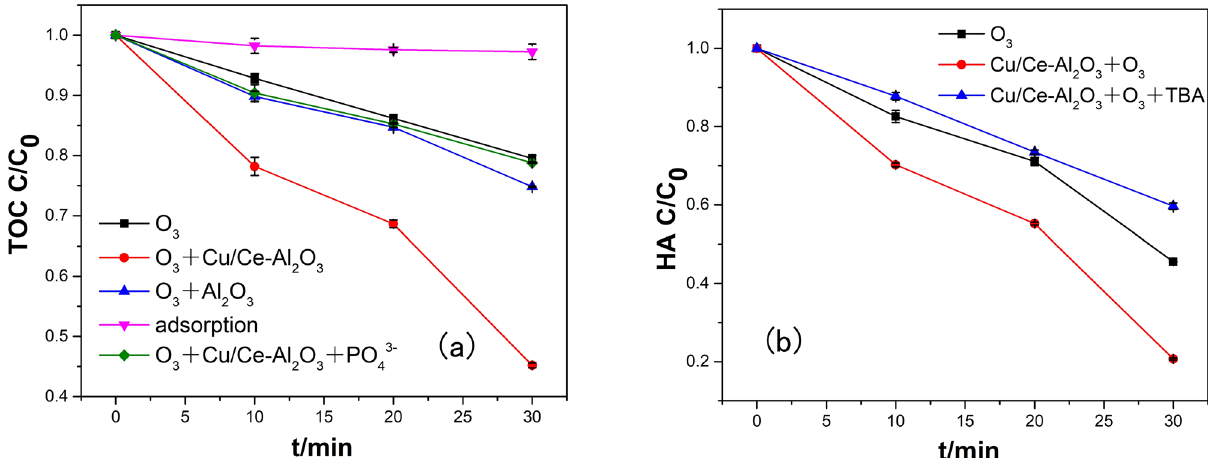
Figure 3. Comparison of HA removal rate among different processes. In ( a ) the square represents the simple ozone reaction, the upper triangle the ozone reaction with the addition of Al 2 O 3 , the circle represents represents the ozone reaction with the addition of Cu/Ce–Al 2 O 3 catalyst, the lower triangle represents the adsorption reaction with the addition of Cu/Ce–Al 2 O 3 catalyst, and the diamond represents the ozone reaction with the addition of Cu/Ce–Al 2 O 3 catalyst and phosphate; In ( b ) the square represents the simple ozone reaction, the circle represents the ozone reaction with Cu/Ce–Al 2 O 3 catalyst , the upper triangle represents the ozone reaction with Cu/Ce–Al 2 O 3 catalyst and TBA (experimental conditions: pH 0 , 6.49; catalyst dosage (if used), 5.0 g/L; gas flow rate, 400 mL/min; ozone concentration (if used), 2.90 mg/L; reaction volume, 1.0 L; reaction time, 30 min; sodium phosphate dosage, 0.4 μmol/L; and tert-butyl alcohol dosage, 10